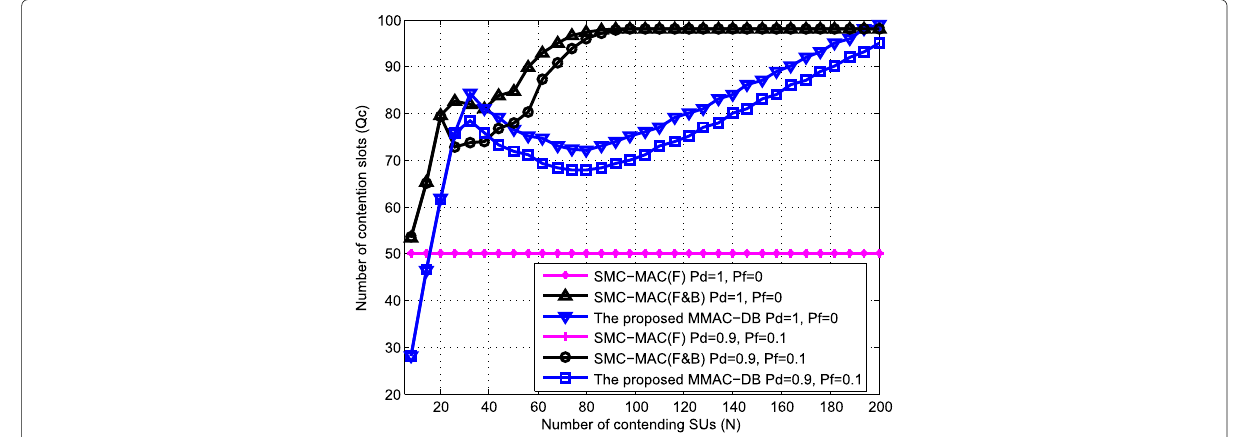
Fig. 12 Number of contention slots with M = 30, α = 0.1. Contention window analysis for scene